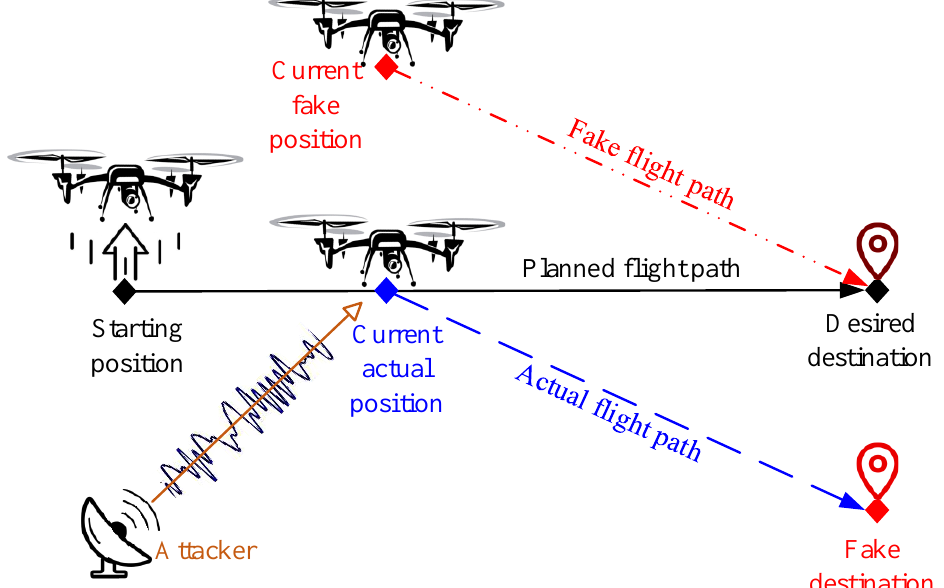
Figure 1. Scenario of GPS spoofing attack on a UAV. A UAV takes off from the starting position and then flies to the desired destination along the planned flight path. At some point, an attacker begins to launch a GPS spoofing attack on this UAV, changing the UAV’s location from the current position to the fake position. With sustained attacks, the ground control station shows that this UAV is flying along the fake flight path to reach the desired destination. However, this UAV is flying along the actual flight path to reach the fake